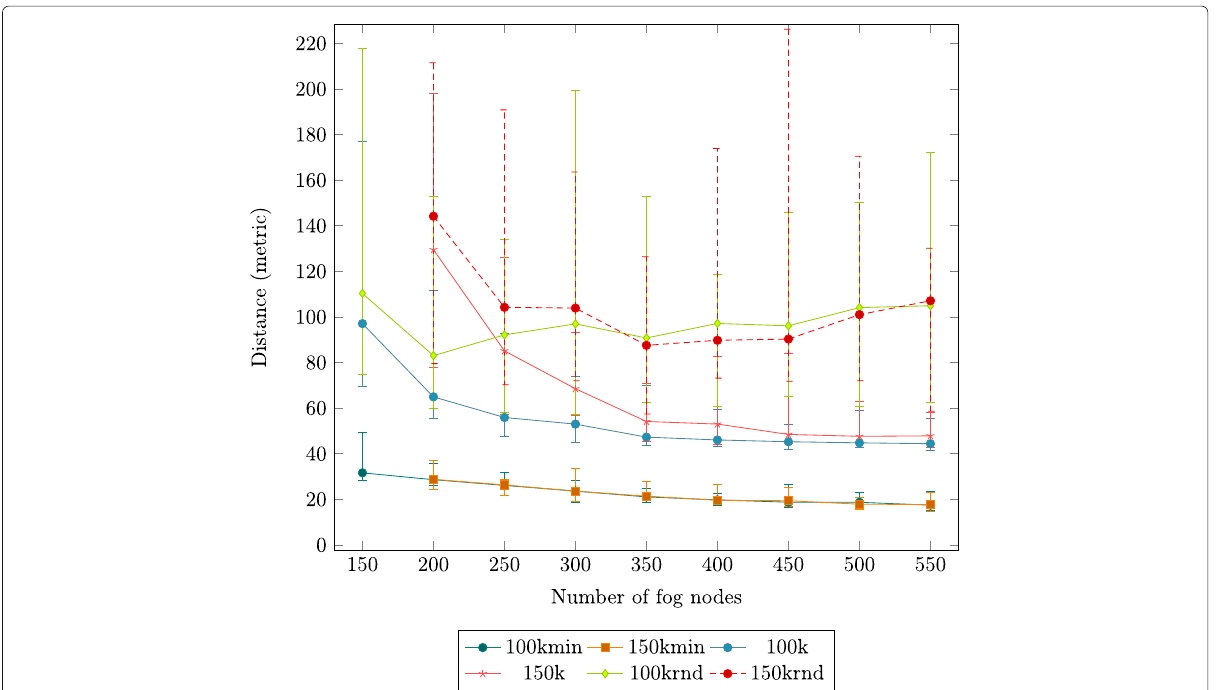
Fig. 8 Average distance for different types of service topologies. Legend numbers represent thousands of edge nodes, min denotes theoretical ideal service topologies, while rnd indicates service topologies where the fog nodes are randomly